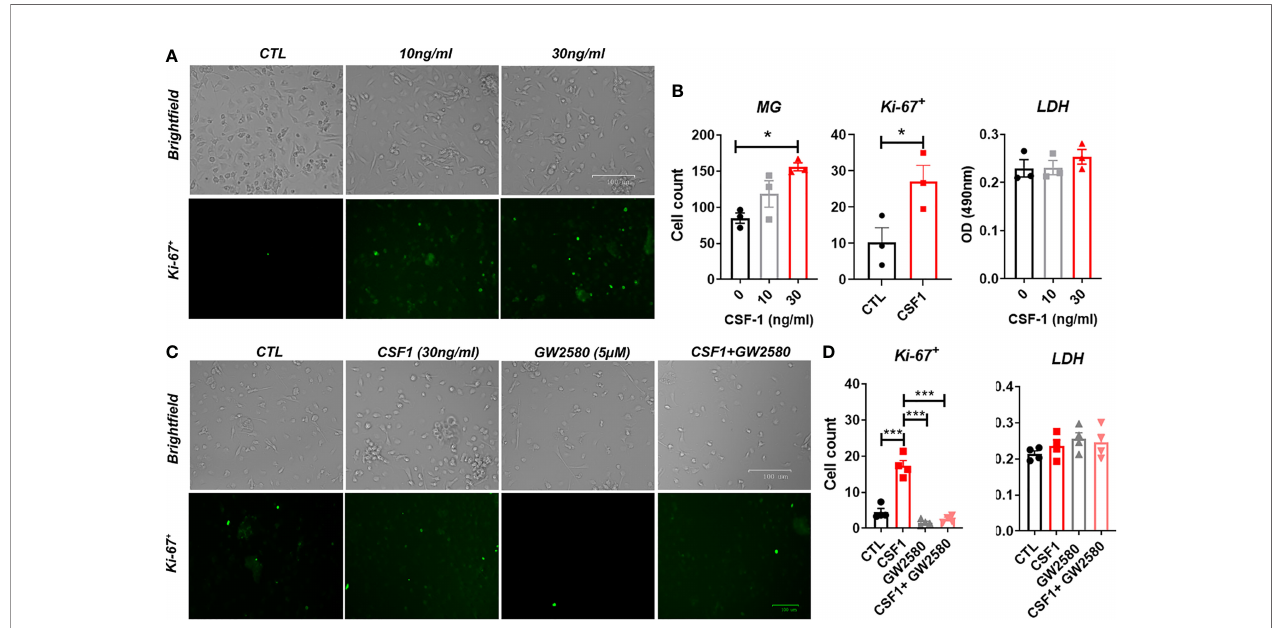
FIGURE 5 | Effect of GW2580 treatment on microglia cell proliferation. (A, B) Primary mouse microglia were stimulated with 0, 10 or 30ng/ml of CSF1 and then stained with 30µg/ml of Ki-67. Cell death was assessed by measuring supernatant levels of LDH. Cells were manually count and represented by the graphs. Data are expressed as means ± standard error (S.E.), n=3 independent experiments per group. (C, D) Cells were treated with either media, with CSF1 (30ng/ml), GW2580 (5µM), or CSF1 and GW2580, then Ki-67. The number of Ki-67 + cells determined by immunohistochemistry were manually counted and represented by the graphs. Data are expressed as means ± standard error (S.E.), n=4 independent cultures per group. Statistical signi fi cance is represented by p-value < 0.05 (*), and p-value < 0.001